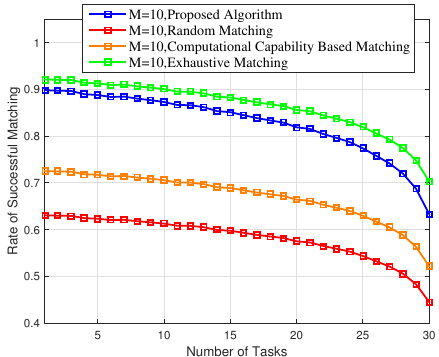
Figure 6. Rate of successful matching of the proposed scheme versus the random matching, CCBM, and exhaustive matching.